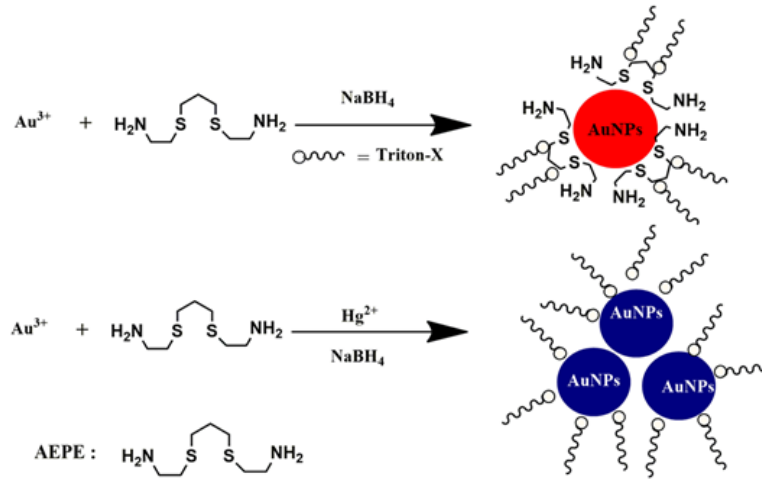
Fig. 6. Proposed mechanism for Hg 2+ -induced colorimetric response of AEPE capped